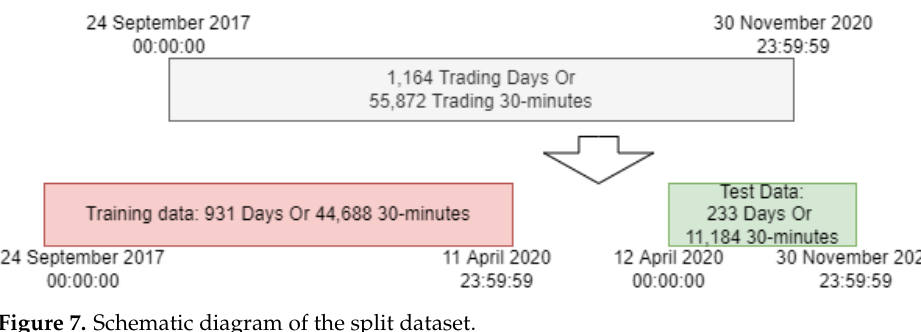
Figure 7. Schematic diagram of the split dataset.